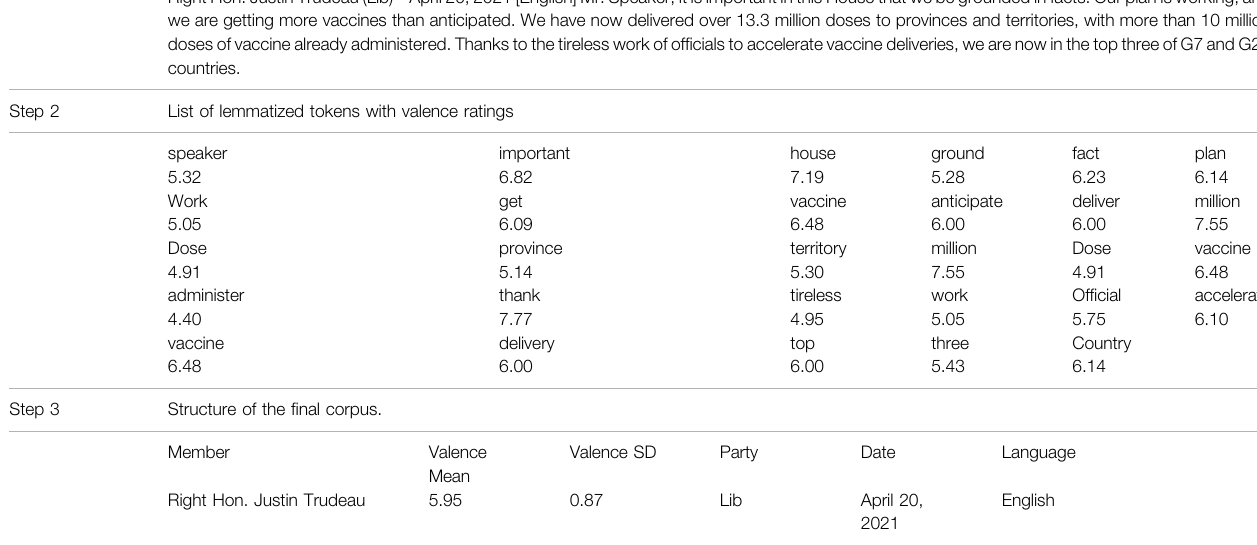
TABLE 4 | A breakdown of the process of obtaining valence ratings for content word tokens in each speaking turn and calculating the average valence of those tokens. Step 1 Format of the original speaking